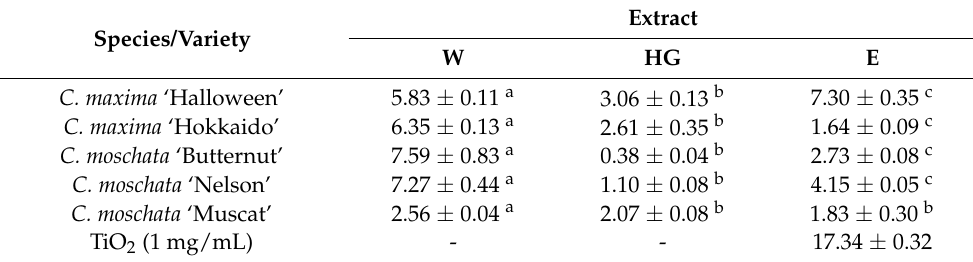
Table 8. In vitro Sun Protection Factor of the Cucurbita sp. peel extracts at 1 mg/mL.